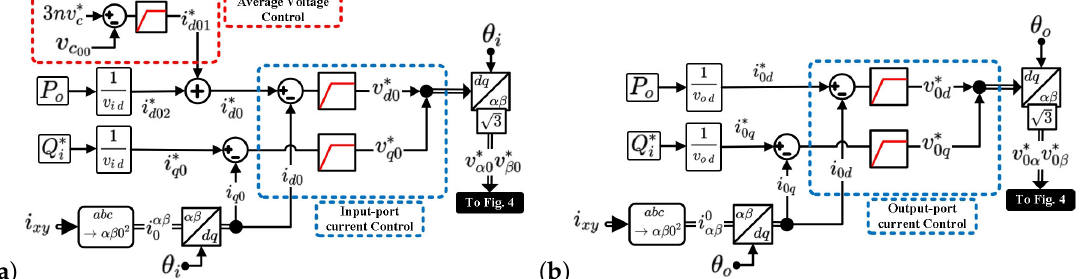
Figure 5. ( a ) Input port power control. ( b ) Output port power